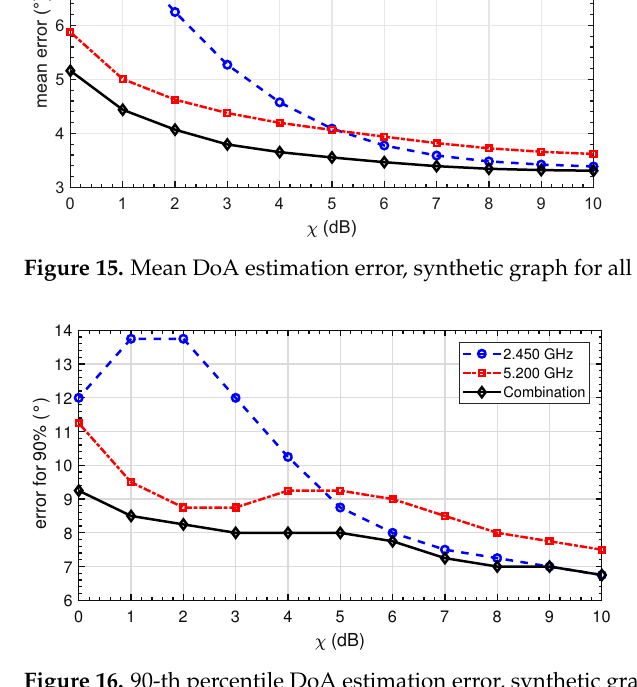
Figure 16. 90-th percentile DoA estimation error, synthetic graph for all D